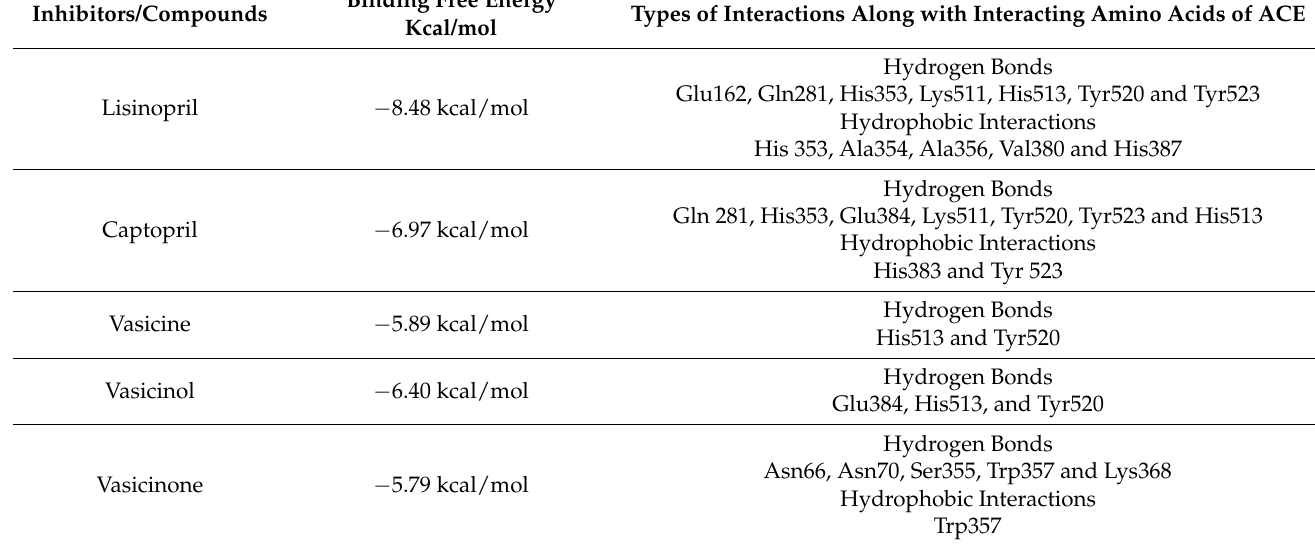
Table 3. Binding free energies of inhibitors/compounds, along with interacting residues of ACE protein.